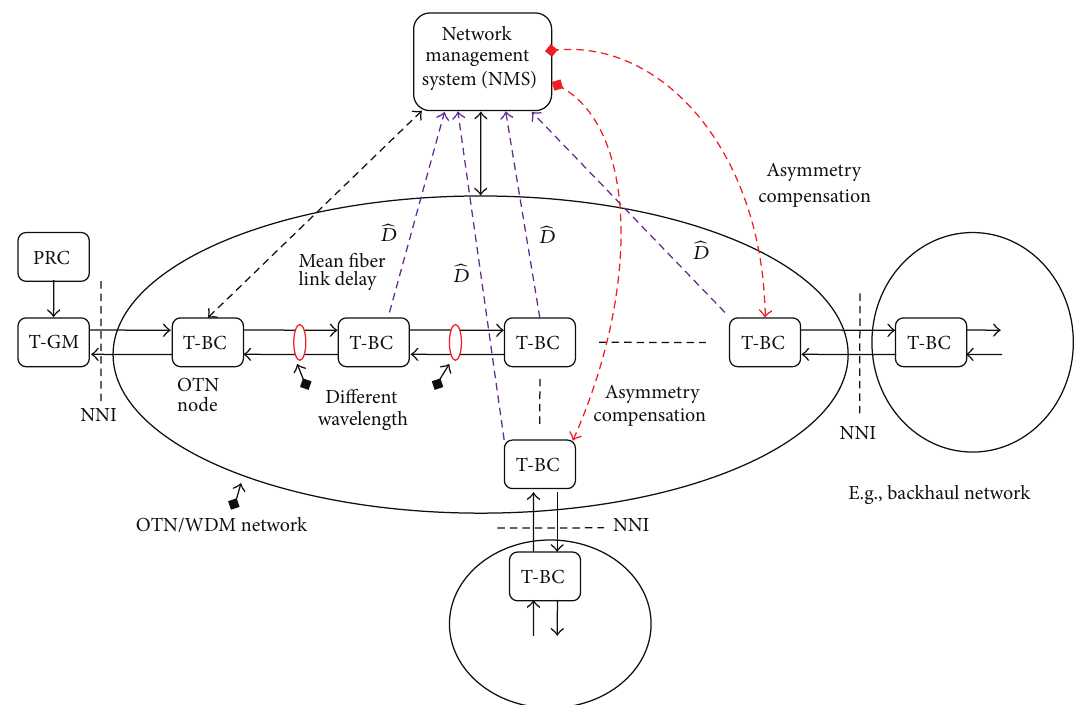
Figure 8: Asymmetry compensation support from control plane.